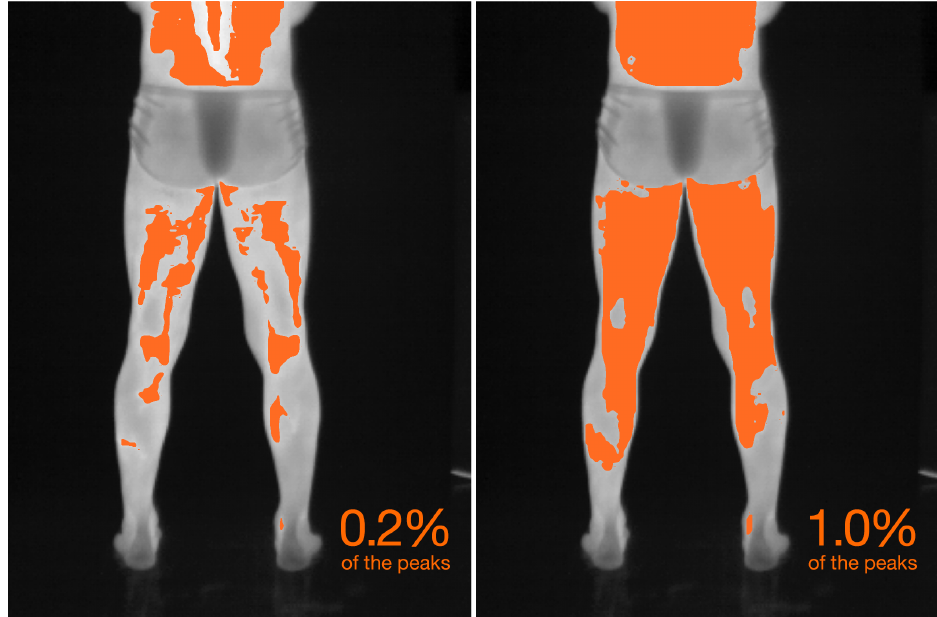
Figure 11. The effect of the region growing stoppage criterion on isotherm extraction. While the ability to adjust this parameter can be useful for medical analysis and provide some flexibility, setting it inadvertently may lead to undesirable